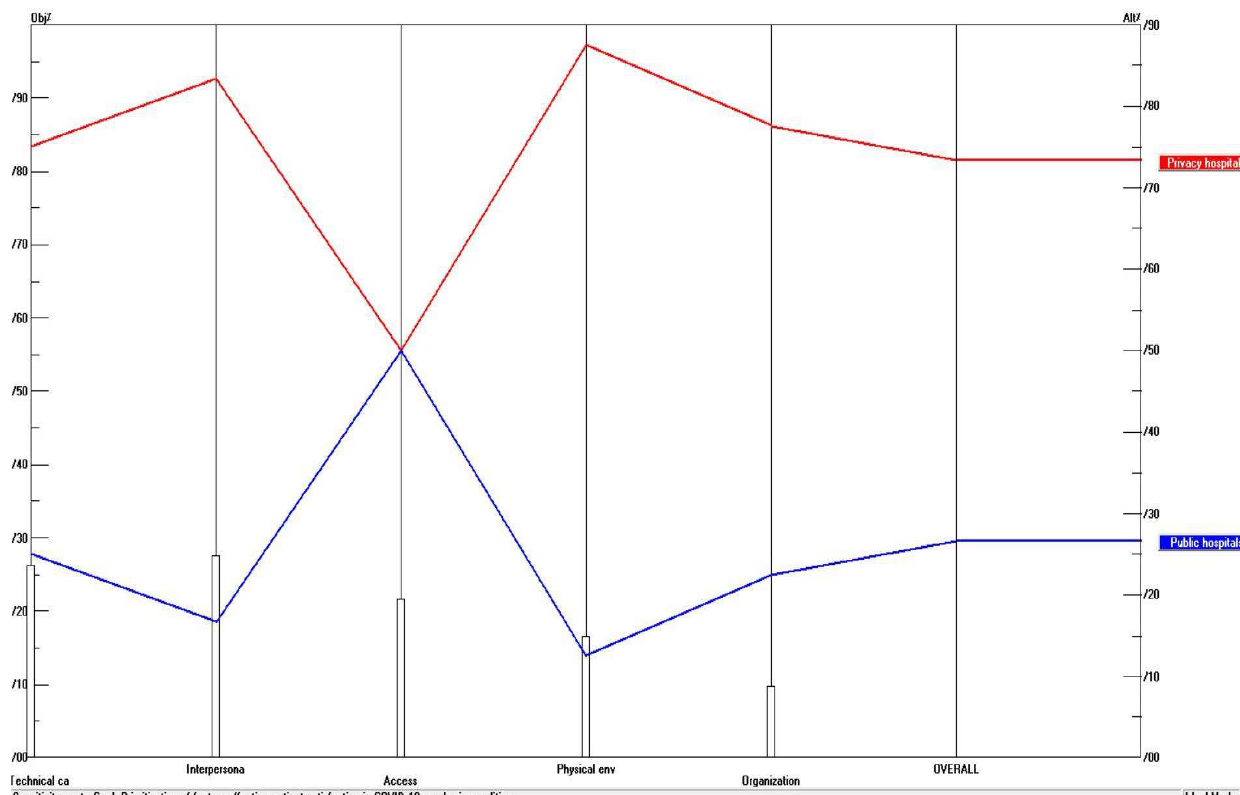
Figure 3. Weighted head-to-head between public and private hospitals.